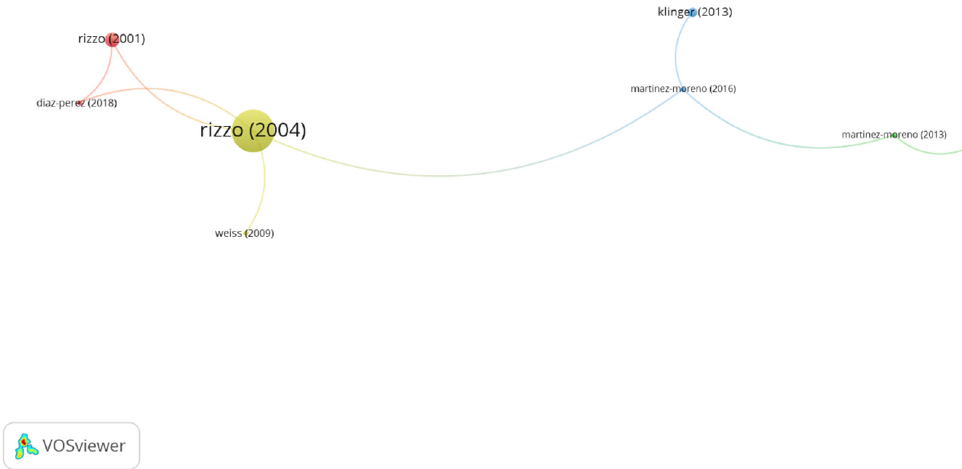
Figure 7. Group 4 citation network. The most cited publication is that of Rizzo (20004).